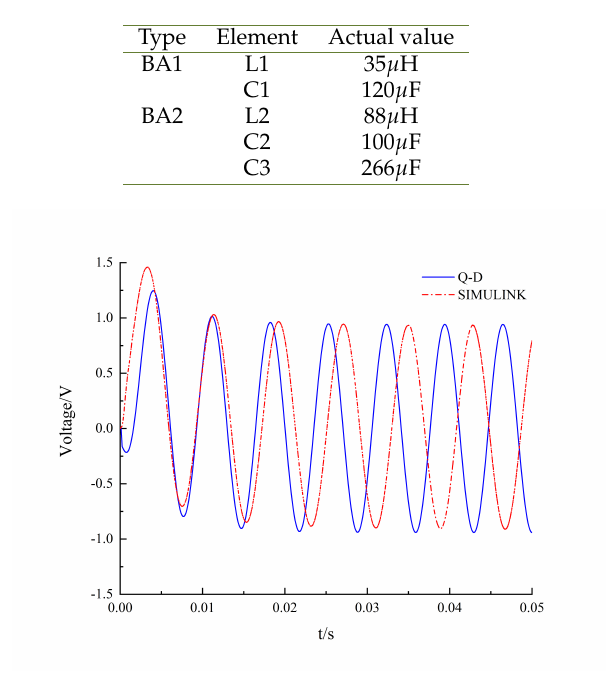
Fig. 7. Simulink model of hybrid model of traction network and ZPW-2000A track circuit. Table 3. Tuning unit parameter table.